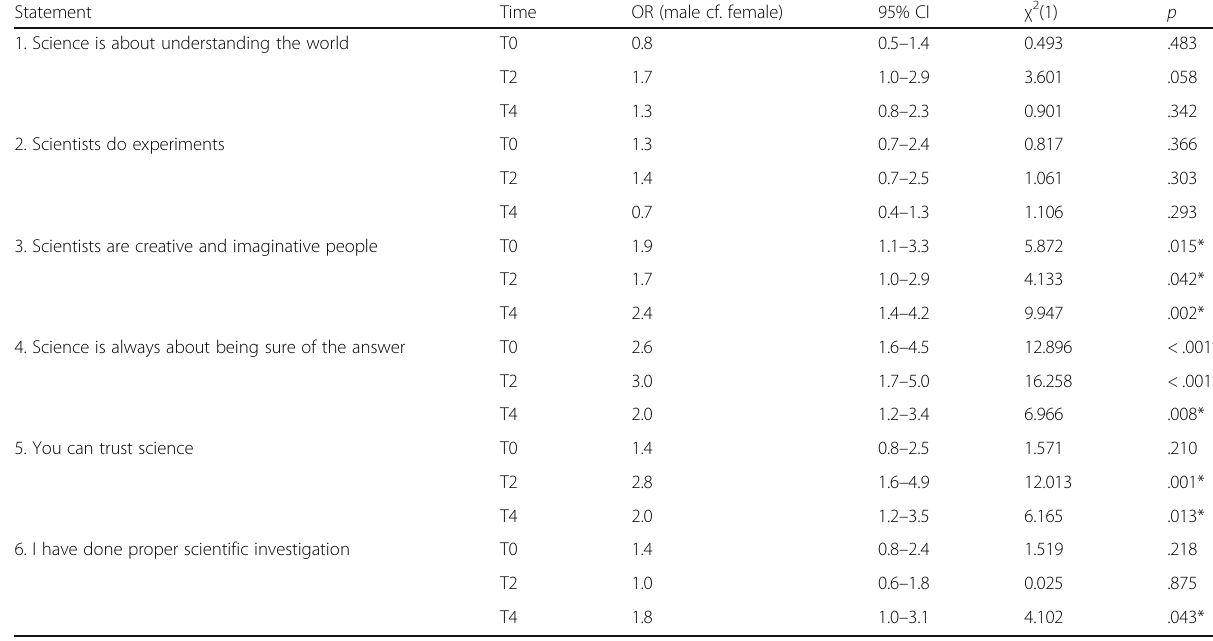
Table 3 Perceptions of science: odds ratio (95% CI), male compared to female responses